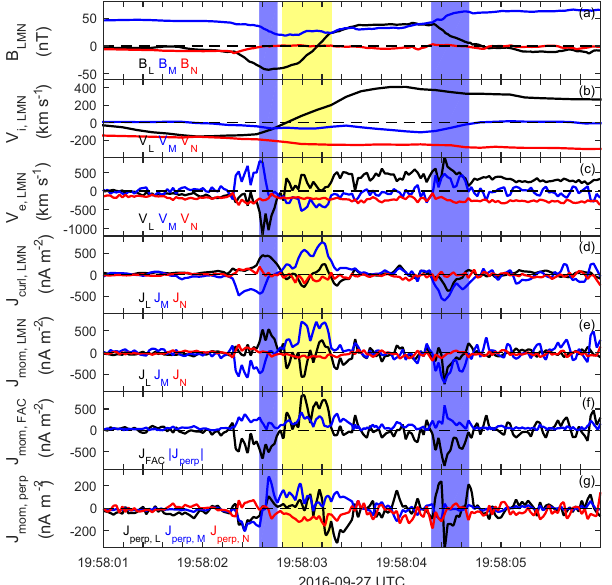
Figure 5. The current density inside the flux rope. (a) The magnetic field, (b, c) the ion and electron velocity, (d) current density com- puted from the curlometer method, (e) current density computed from plasma moments, (f) the parallel and perpendicular currents, and (g) the perpendicular current in LMN. The vertical yellow and blue bars indicate the current filaments in the core region and at edges of the flux rope.